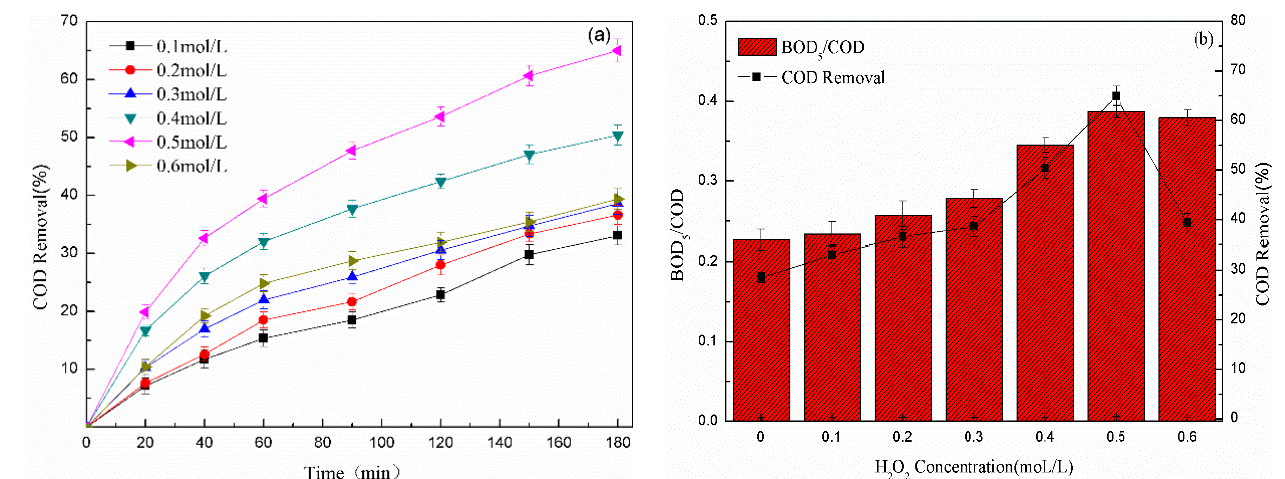
Figure 6. Effect of H 2 O 2 concentration on ( a ) COD removal and ( b ) BOD 5 /COD of pharmaceutical wastewater (initial pH = 2.0, catalyst dosage = 10.0 mol/L, light distance = 20 cm).